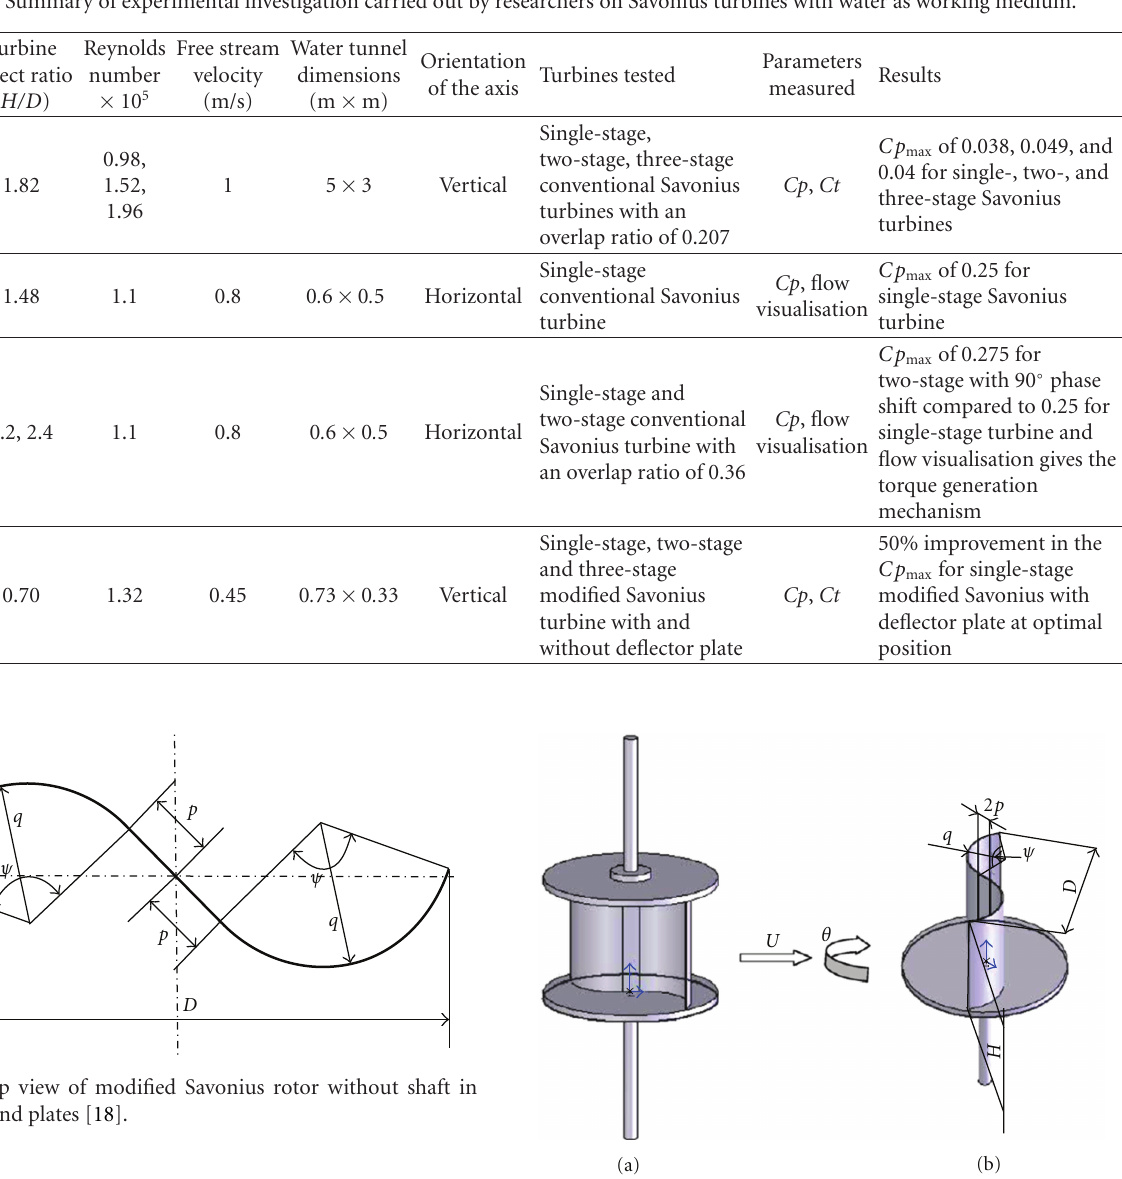
Figure 4: (a) Modified Savonius rotor without shaft in between end plates. (b) Geometrical parameters of modified Savonius rotor